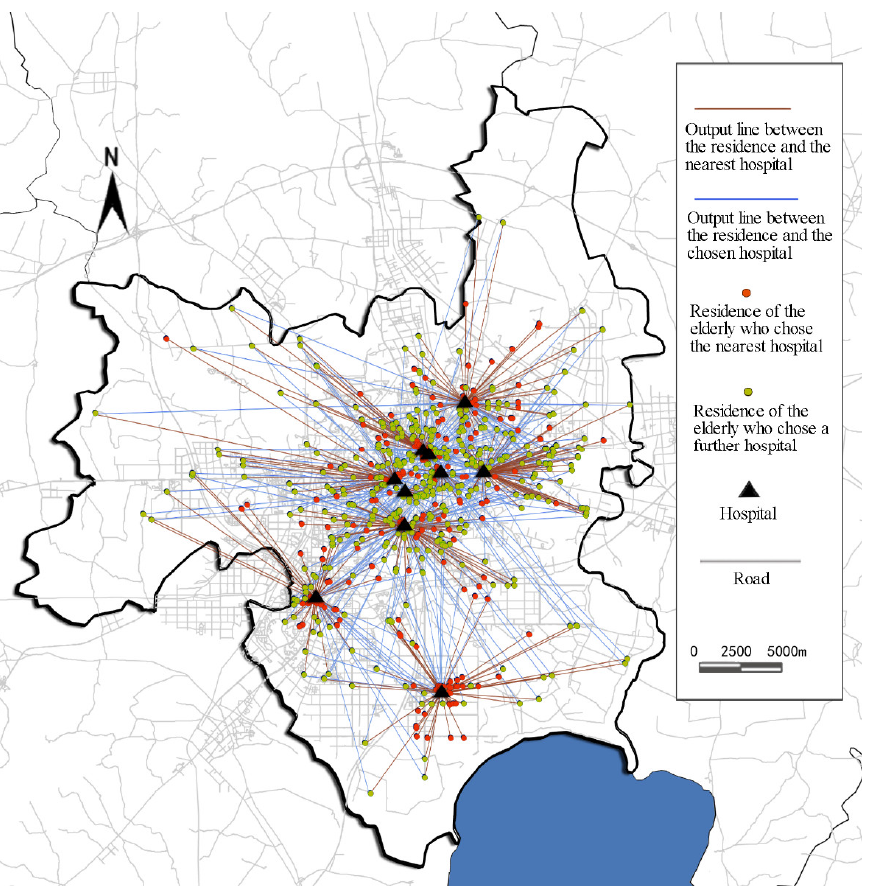
Figure 3. Output lines from the elderly’s residences to the nearest and the visited hospitals according to the OD cost matrix